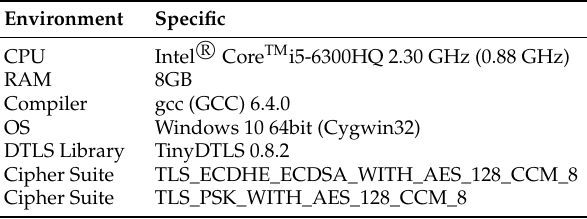
Table 4. Tiny DTLS-PSK 0.8.2 and Tiny DTLS-ECC 0.8.2 environments for evaluation.